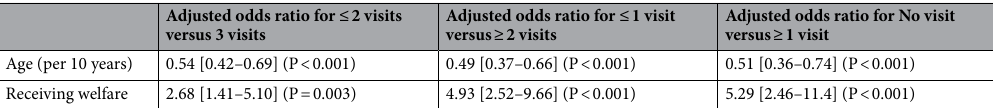
Adjusted odds ratio for ≤ 2 visits versus 3 visits